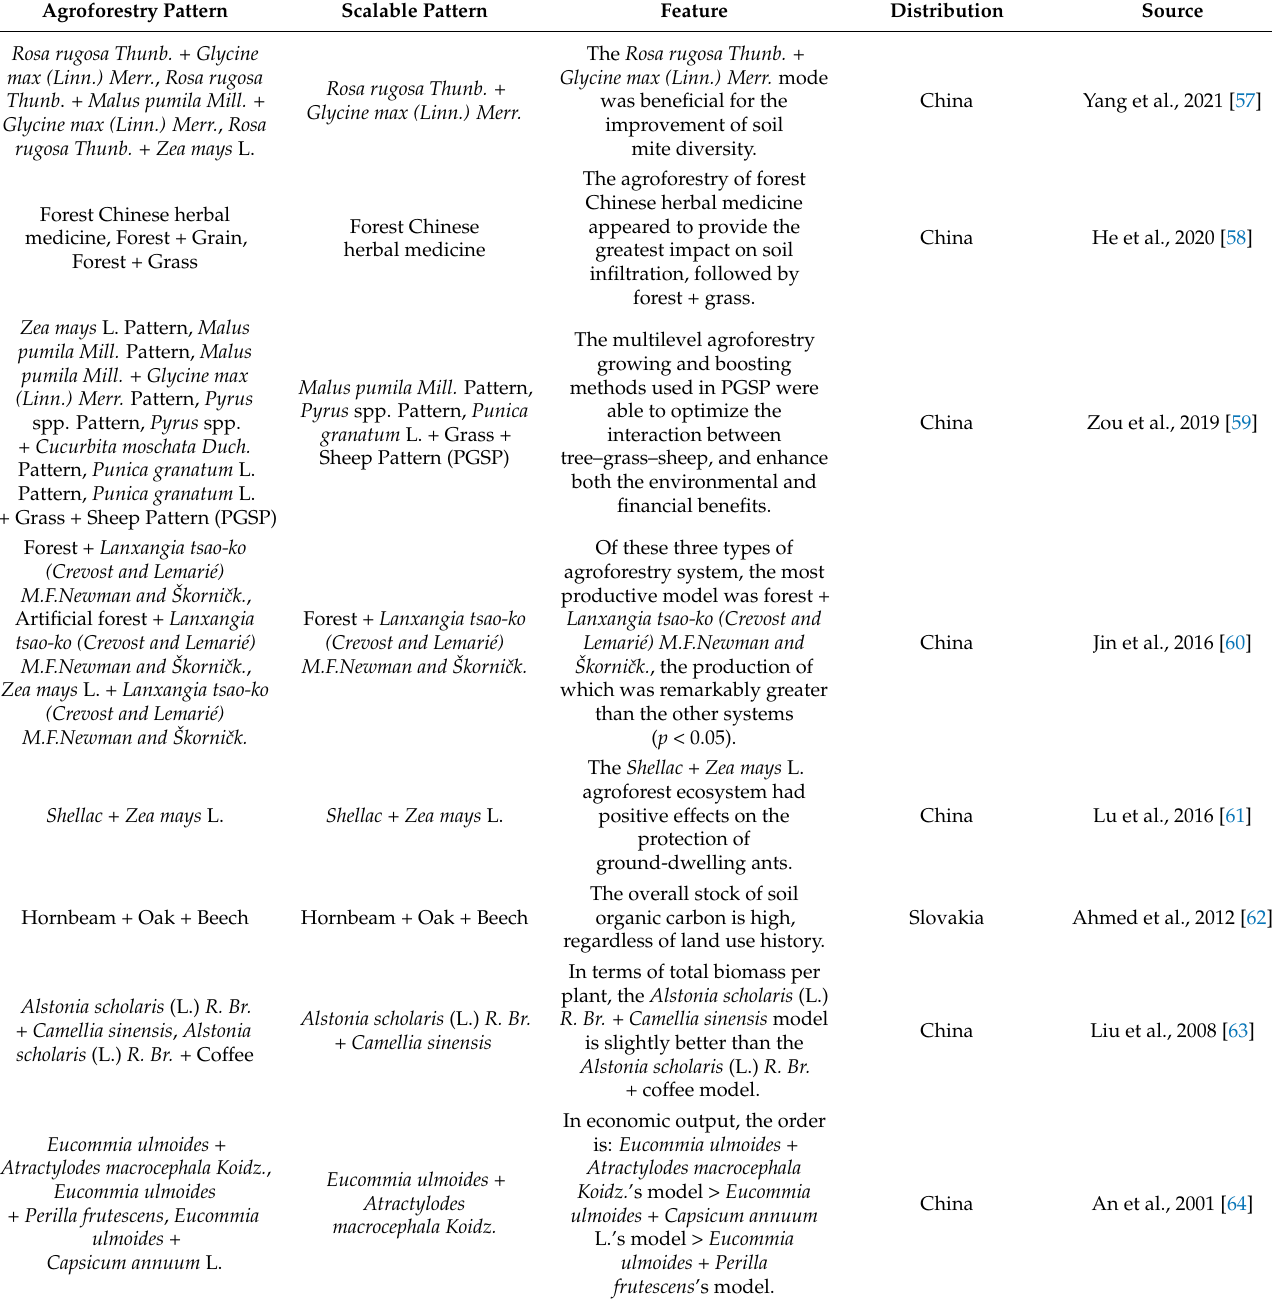
Table 2. The characteristics of different agroforestry patterns in karst